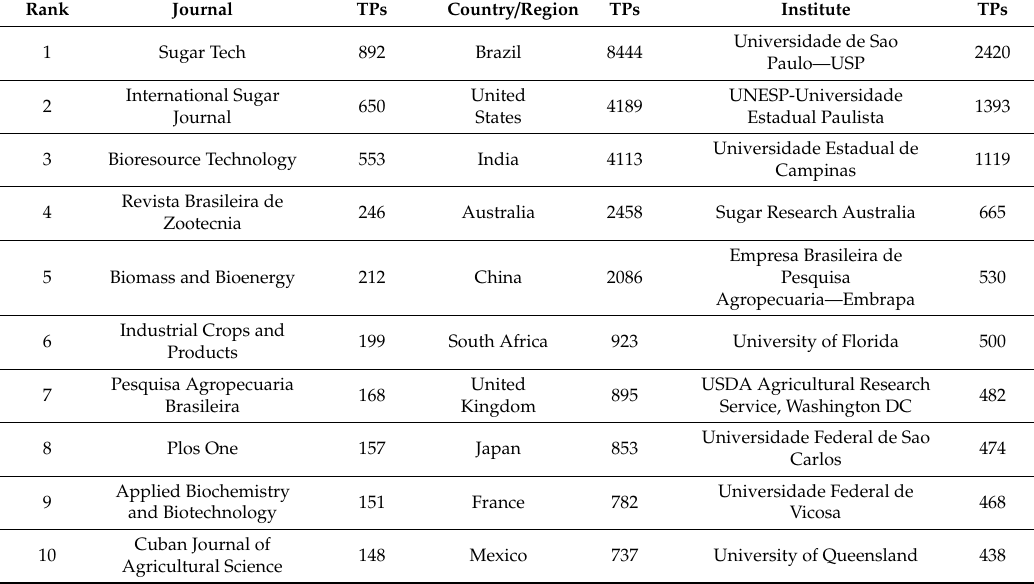
Table 1. Journals, institutes, and countries with published research on sugarcane.